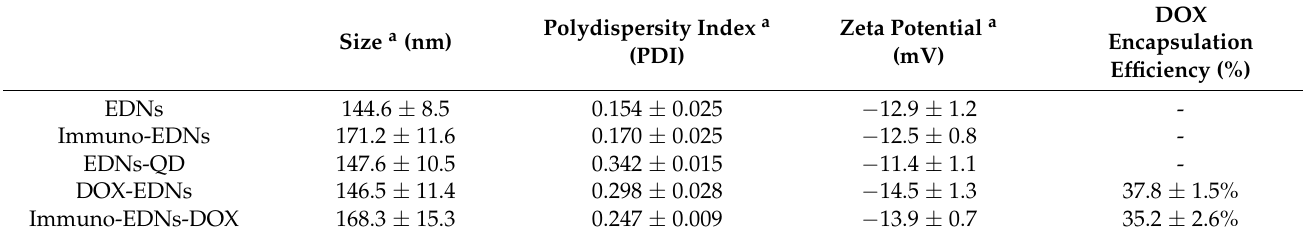
Table 1. Physicochemical characterization of erythrocyte-derived nanoparticles (EDNs).